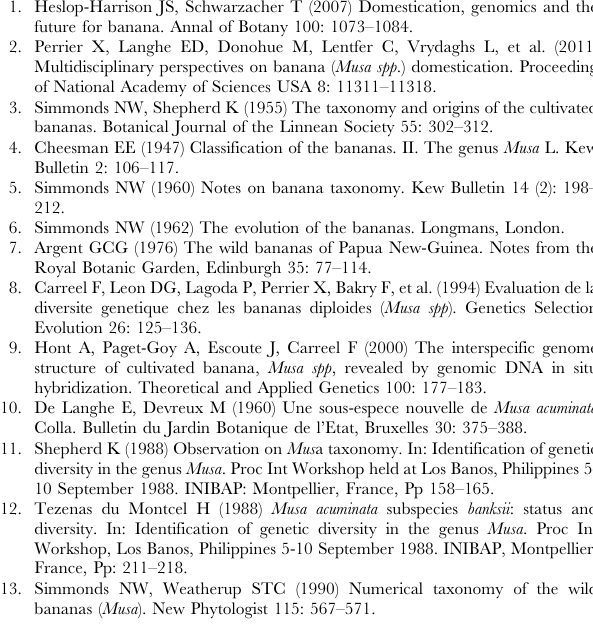
Figure S1 Structures of Waxy and Adh 1 genes in Musa and the positions of each primer used in this study. Table S1 The sequences of primers and the information of Waxy and Adh1 gene used in this